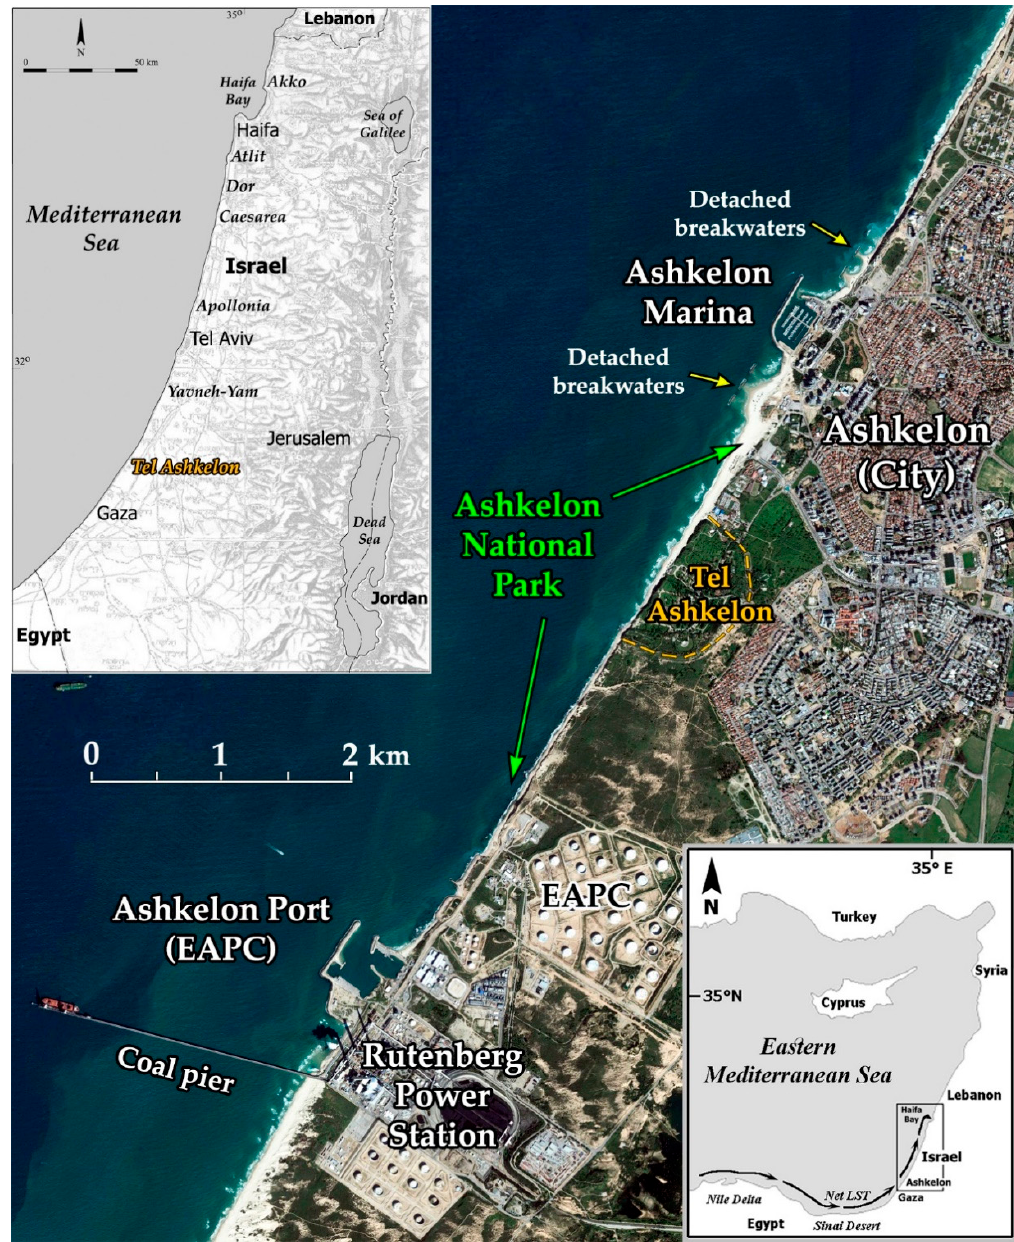
Figure 1. Ashkelon coast, the main marine constructions and Tel Ashkelon site (Photo: Google Earth image, 28 January 2016) (EAPC—Eilat-Ashkelon Pipeline Company); The Mediterranean coast of Israel and its main ancient coastal sites (top left inset); The Nile littoral cell longshore sand transport direction (black arrows), from the Nile Delta to Haifa Bay (bottom right inset).